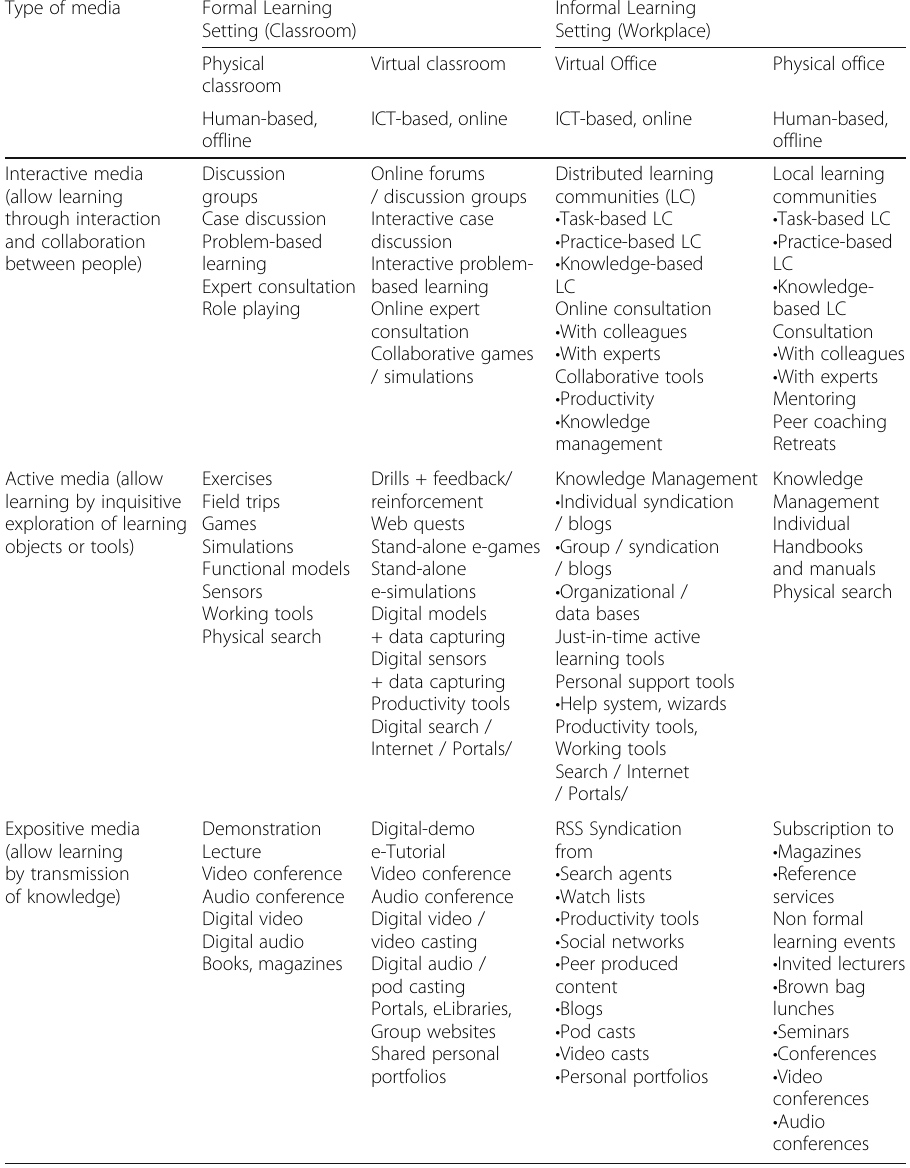
Table 2 Resources to promote learning using blended learning environments in formal and non-formal settings Source: (Galvis et al., 2006, p.